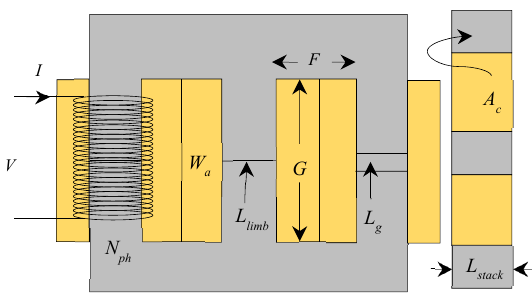
Figure 1. Layout of 3 Phase EE-core Inductor.